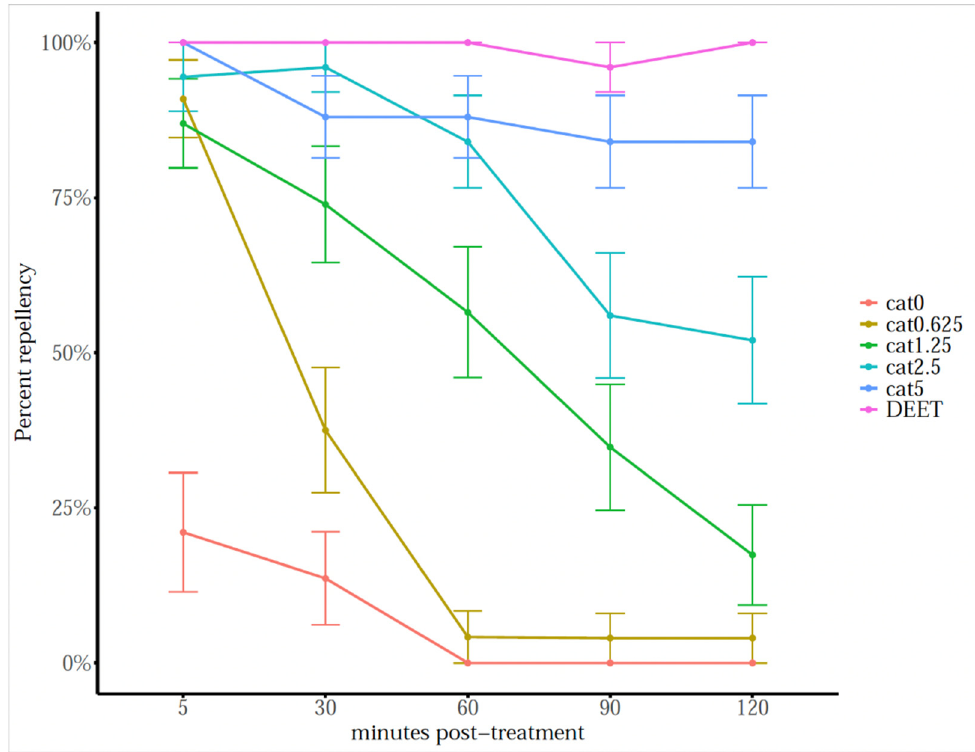
Figure 6. Mean percentage (±SEM) of ticks repelled by catnip essential oil at different concentrations and by DEET (25% v / v ) in horizontal filter paper bioassays at different time points. n = 25 per concentration.